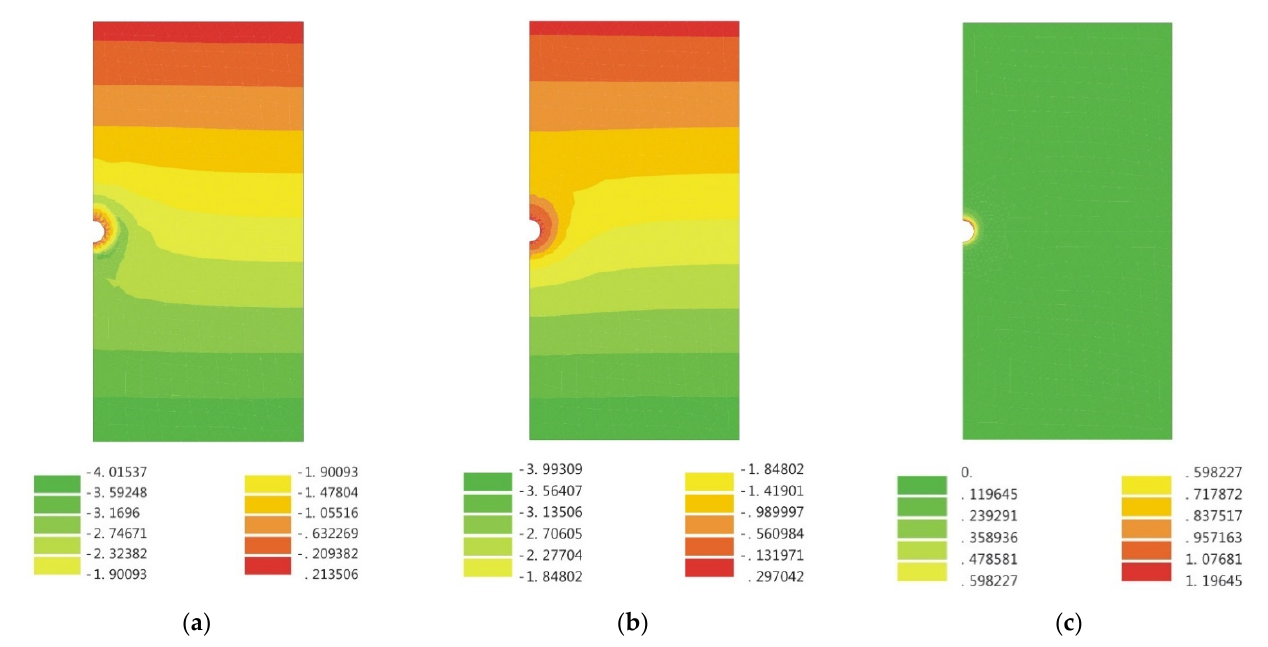
Figure 8. Iso-value contour plots of the final stress/displacement distribution around the tunnel under the initial isotropic stress condition ( K o = 1.0) in finite element analysis. ( a ) Major Principal stress (MPa), ( b ) Minor Principal stress (MPa), and ( c ) total displacement (m).